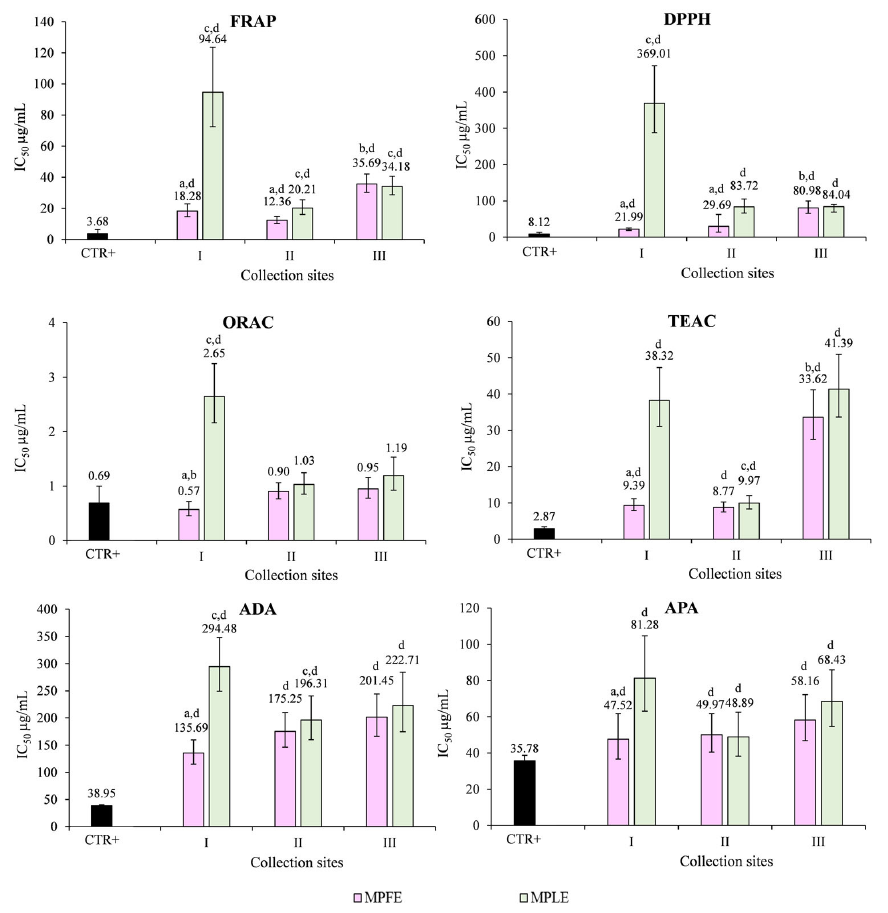
Figure 6. Antioxidant and anti ‐ inflammatory properties of leaf and flower extracts of M. pulegium (MPLE and MPFE, respectively) investigated by in vitro cell ‐ free assays. FRAP, ferric ‐ reducing antioxidant power; DPPH, scavenging activity against 2,2 ‐ diphenyl ‐ 1 ‐ picrylhydrazyl radical; ORAC, oxygen radical absorbance capacity; TEAC, trolox equivalent antioxidant capacity; ADA, albumin denaturation assay; APA, antiprotease activity. a p < 0.001 vs. respective MPLE; b p < 0.001 vs. other MPFE; c p < 0.001 vs. other MPLE; d p < 0.001 vs. CTR+ (trolox and diclofenac sodium for antioxidant and anti ‐ inflammatory assays, respectively).